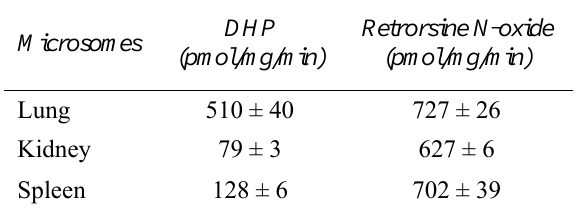
Table 2: Quantification of DHP and retrorsine N-oxide formation in an in vitro PA metabolism with